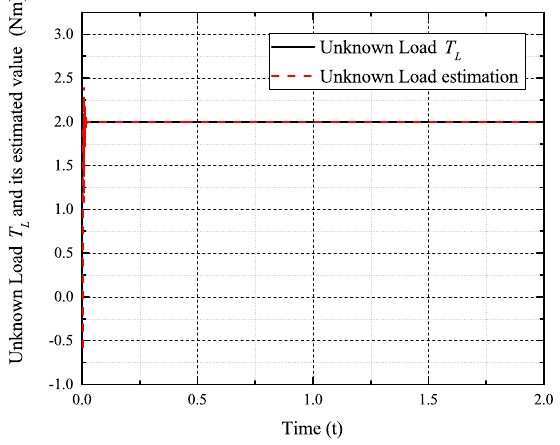
Figure 22. unknown load disturbances T L and its estimated value ˆ T L .